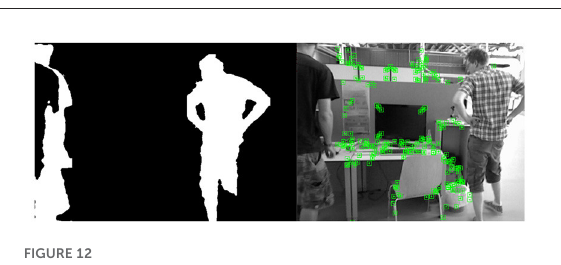
FIGURE12 The feature collection effect of our method under the TUM data set fr3/w xyz.